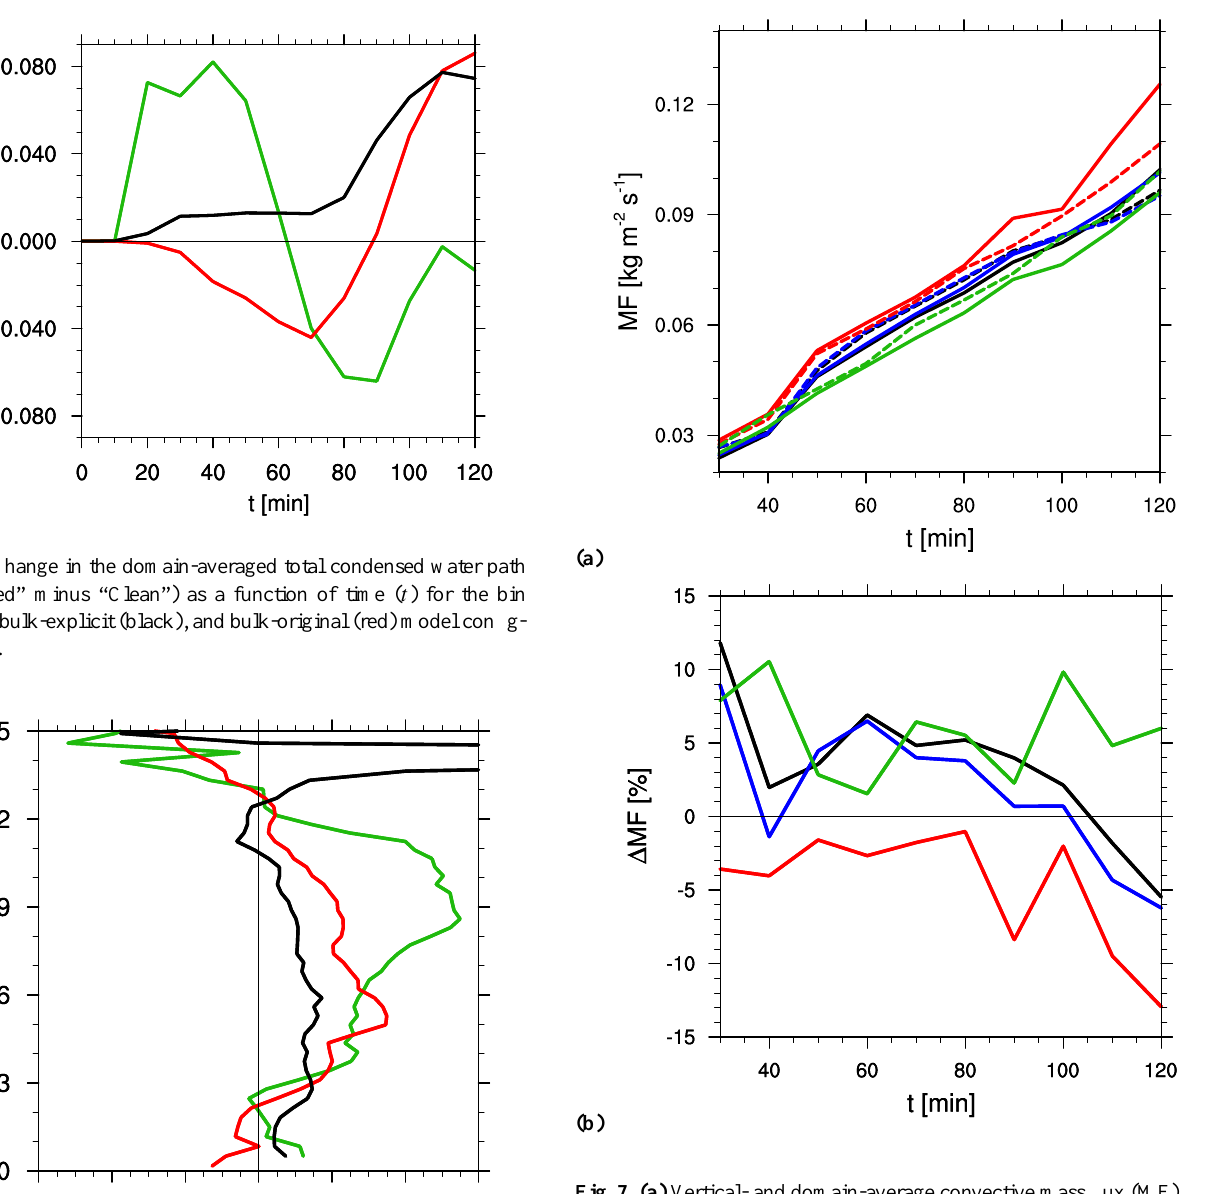
Fig. 7. (a) Vertical- and domain-average convective mass flux (MF) between 2.1 and 9.1km and (b) the relative change in MF for an in- crease in aerosol loading. Depicted here are only the “Clean” (solid) and “Polluted” (dashed) aerosol scenarios for the base simulation setup. All four model configurations are presented, i.e., bin (green), bulk-explicit (black), bulk-cond (blue), bulk-original